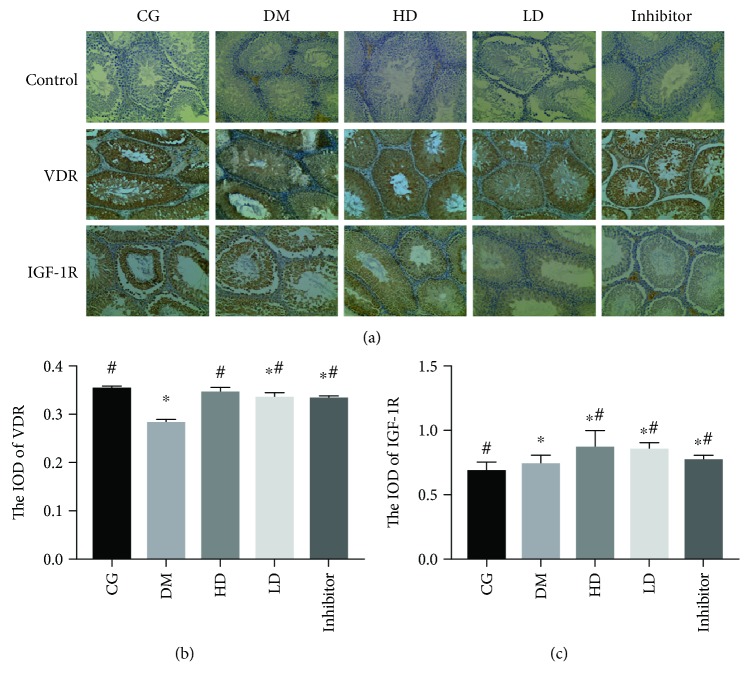
(a) Immunohistochemical analysis of the expression of VDR and IGF-1R in each group (×100). (b, c) Immunohistochemical analyses of VDR and IGF-1R in each group. IOD: integrated optical density. In groups treated with vitamin D, VDR expression was more strongly positive than that in the DM group. Compared with the DM group, the integrated optical density for other groups was significantly different (p < 0.05). There were no significant differences in VDR expression among the LD, HD, and CG groups (p > 0.05). Immunohistochemical analysis showed that the expression of IGF-1R in the DM group was significantly lower than that in the CG, HD, and LD groups (p < 0.05). ∗p < 0.05 versus the CG group; #p < 0.05 versus the DM group.